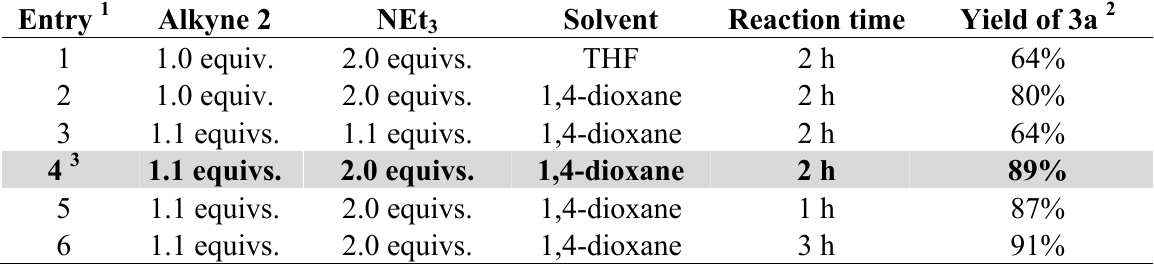
Table 1. Optimization study for the synthesis of 1-( p -anisyl)-3,3-diethoxyprop-1-yne ( 3a